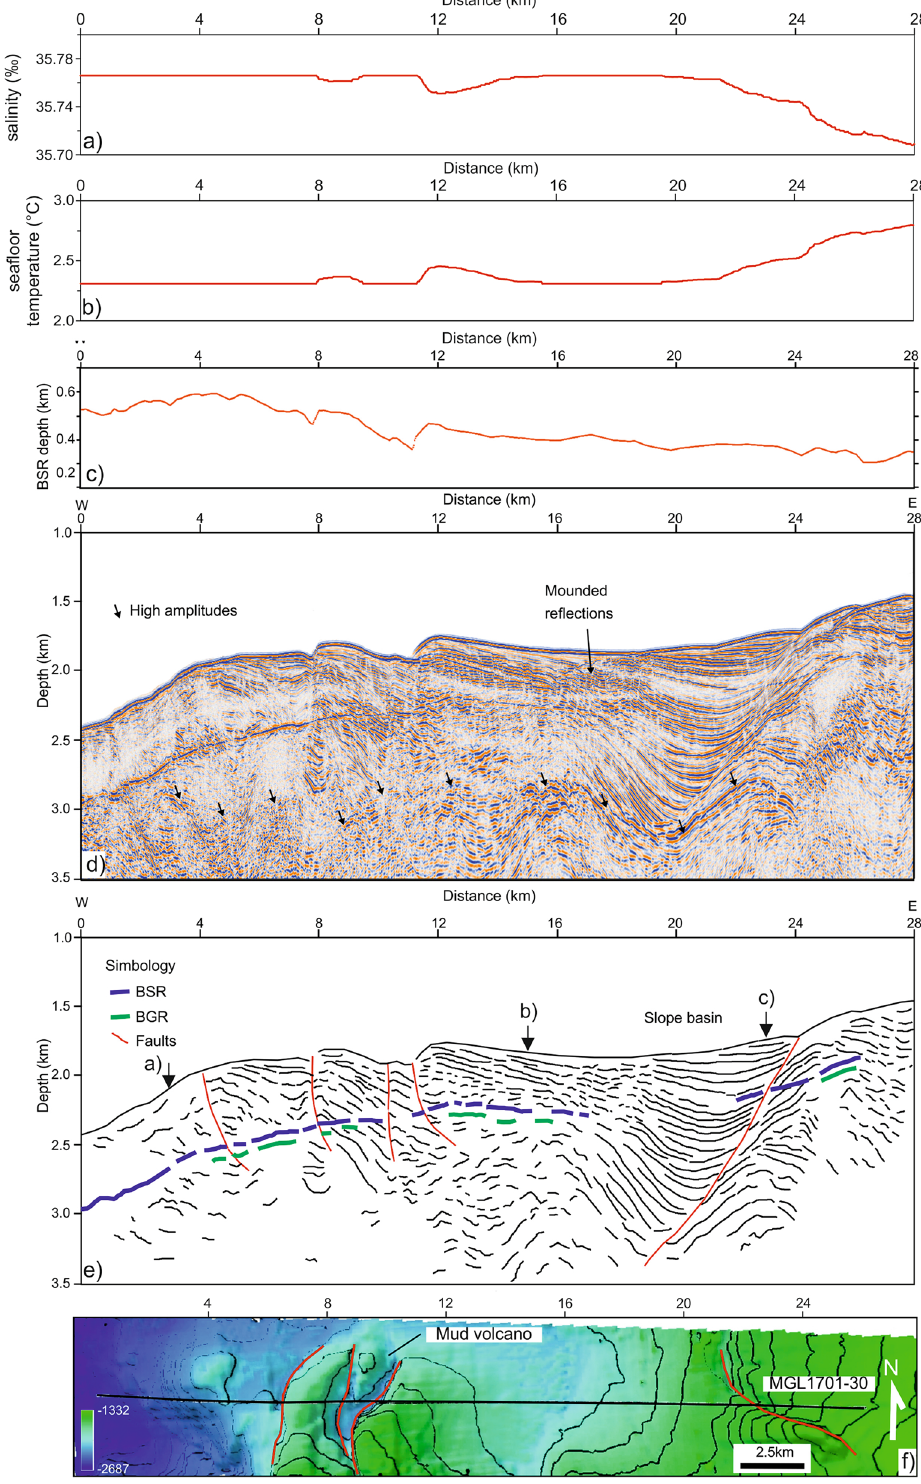
Figure 2. Pre-stack depth migrated and line drawing sections. ( a ) salinity variation along the line; ( b ) seafloor temperature; ( c ) BSR depth profile, ( d ) pre-stack depth migrated section, ( e ) line drawing section and ( f ) bathymetric map across the seismic line. This grid has a size of 103 × 103 m. The black arrows in ( e ) indicate the deeper reflectors, as described in the text. The red lines in ( f ) indicate the main faults. In the sections, the main features are indicated. The map in ( f ) was generated using ArcGIS (v. 10.4.1; www. esri.